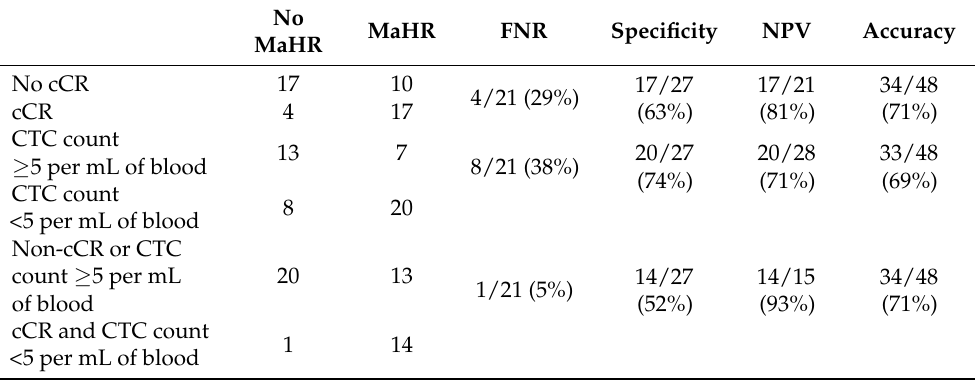
Table 3. Accuracy of circulating tumor cells and clinical response evaluation in the prediction of major histopathological response. Abbreviations: MaHR, major histopathological response; cCR, clinical complete response; FNR, false negative rate; NPV, negative predictive value; CTCs, circulating tumor cells. Data are presented as counts and